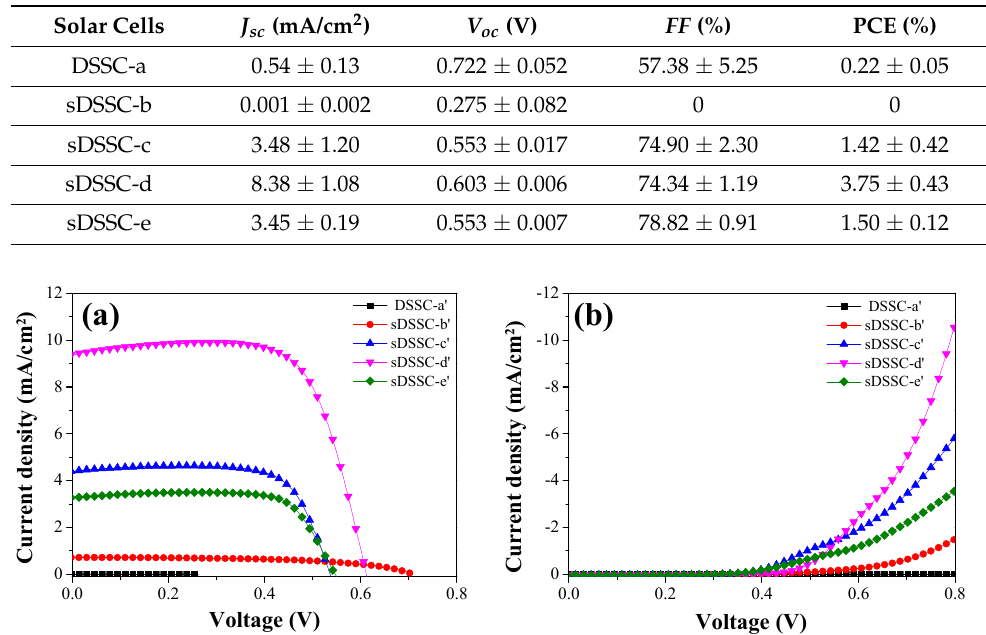
Table 3. Averages and standard deviations of cell performance measured using four cells with five different types of RM.